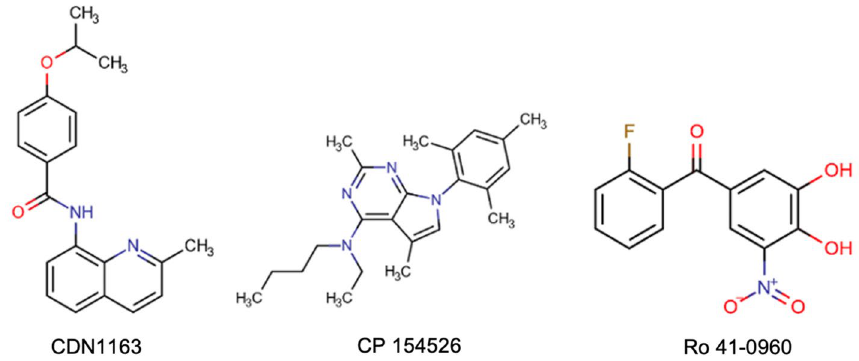
Figure 1. Structures of three activators known to target the transmembrane domain of the calcium